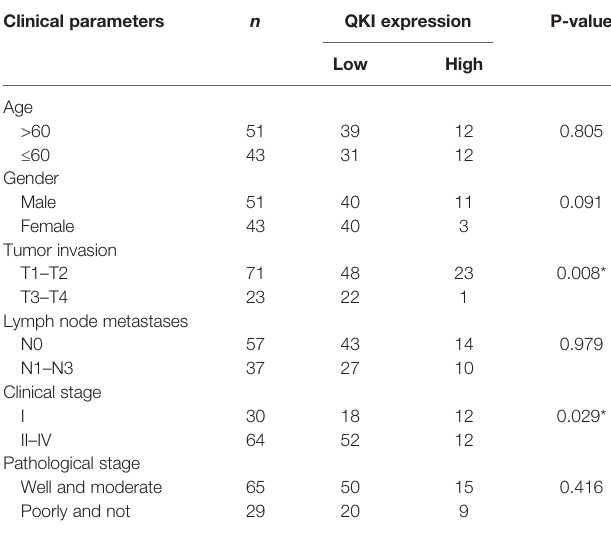
TABLE 1 | Association between QKI expression and clinical parameters in patients with NSCLC. Clinical